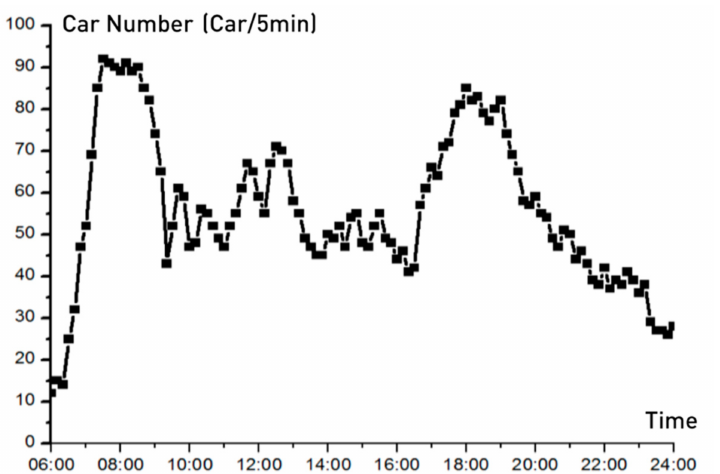
Figure 3. Road vehicle density